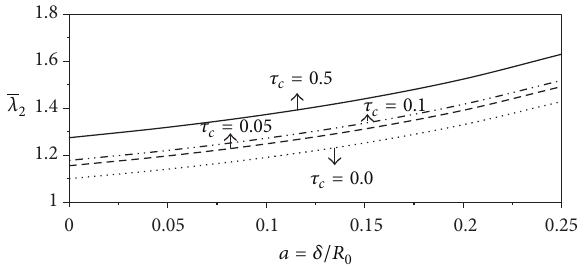
Figure 19: Variations of flow resistance 𝜆 2 with stenosis height 𝛿/𝑅 0 for different values of yield stress 𝜏 𝑐 .